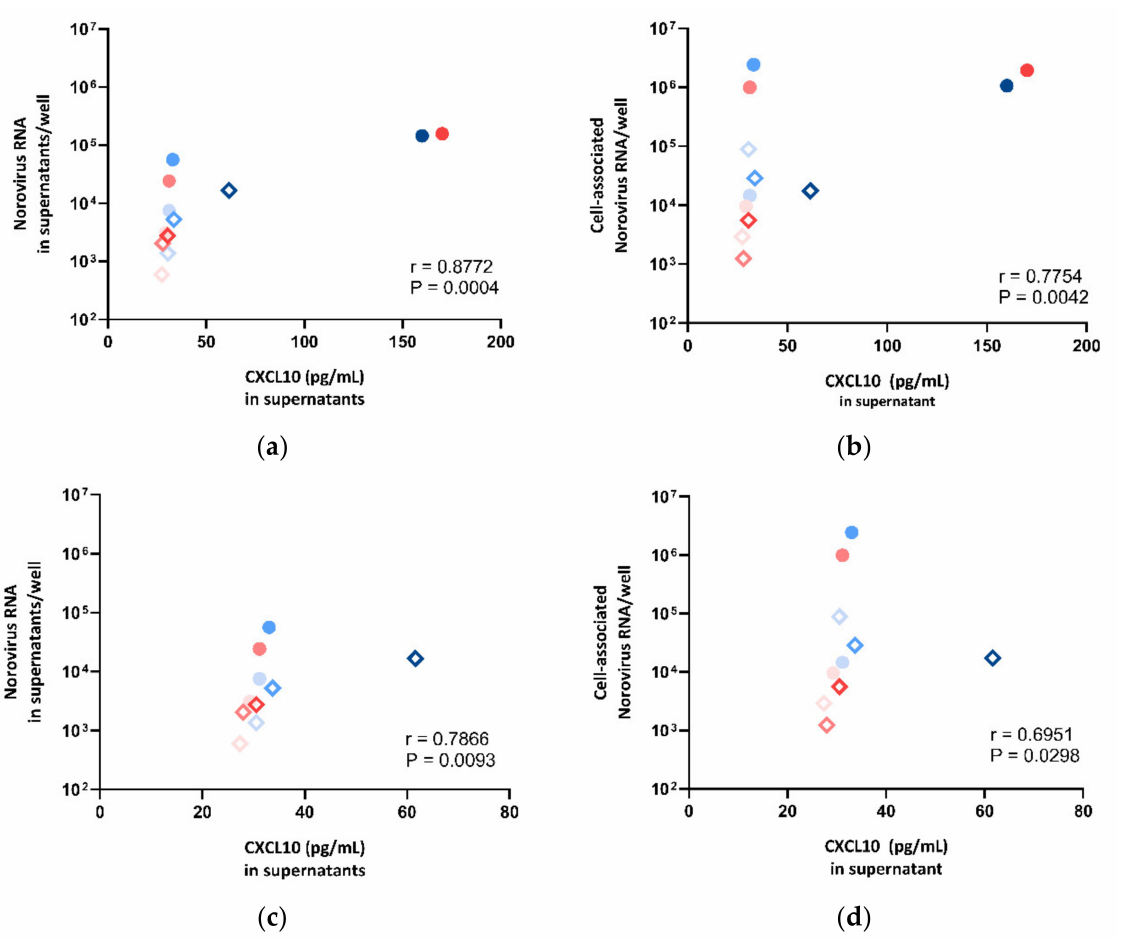
Figure 7. Correlation between norovirus RNA in ( a ) cell lysates, ( b ) supernatants, ( c ) cell lysates after dropping two outliers and ( d ) supernatants after dropping two outliers against CXCL10 concentration measured in supernatants, where the symbol shape indicates the enteroid line used: circles represent CUHK-ED-2, and hollow rhombuses represent CUHK-ED-3. The colour indicates the virus strain for inoculation: blue was used for CUHK-NS-1127 and pink was used for CUHK-NS-1190. The gradient of colour change illustrates the time of sampling: the lightest colour denotes 1 h post-inoculation (hpi), the colour in between denotes 24 hpi and the darkest colour indicates 72